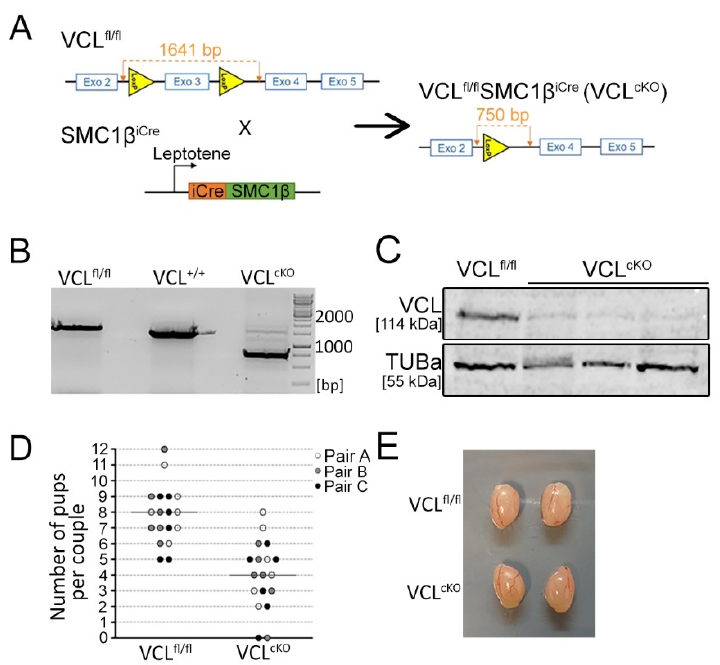
Figure 4. Confirmation of VCL depletion. Cre-mediated excision of VCL exon 3 was confirmed by PCR with the following products. ( A ) Mice with two genotypes were cross-bred, gaining VCL conditional knock-out (VCL cKO ) in primary spermatocytes. Using the scheme, the size of the PCR product of the floxed 3 rd VCL exon (i.e., VCL fl/fl ) was determined, which is 1641 bp. After Cre-mediated excision, the final PCR product 750 bp was obtained, confirming the depletion of exon 3; ( B ) PCR genotyping of VCL-flox VCL allele (VCL fl/fl, , 1641 bp), wild-type VCL (VCL +/+ , 1500 bp), and